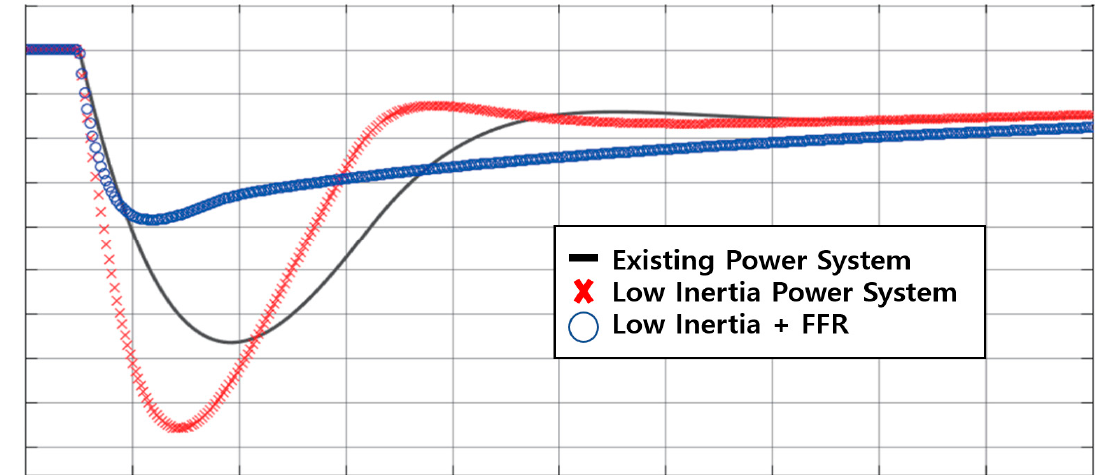
Figure 2. Frequency response according to the change of system inertia constant and reserve force [6].